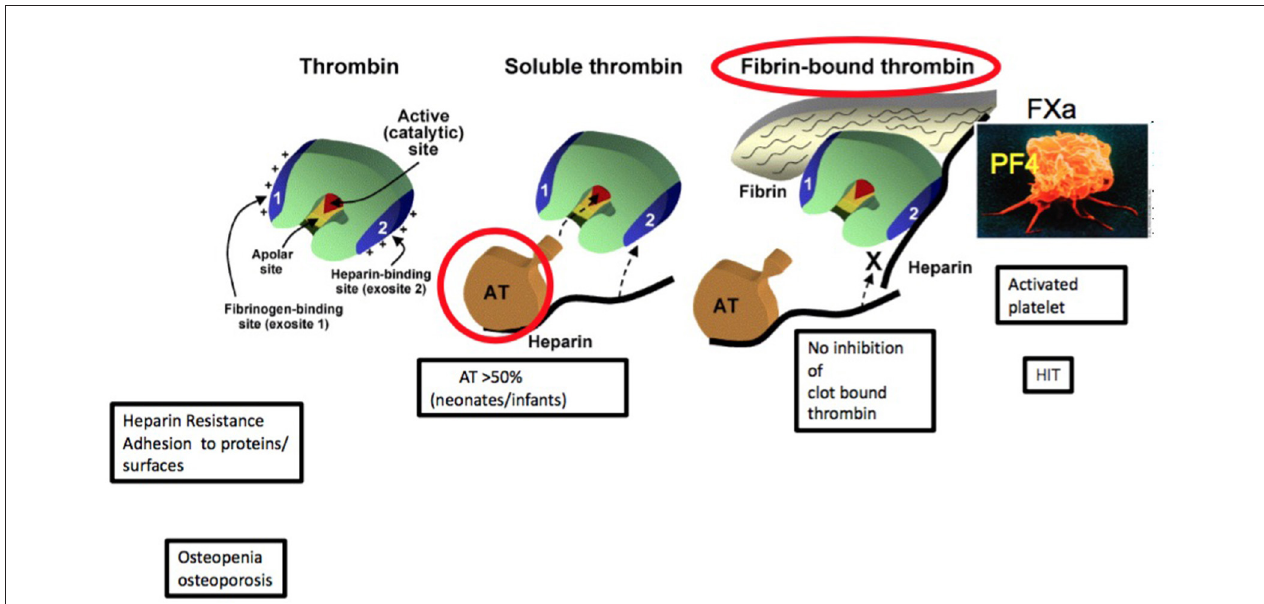
FIGURE 2 | Heparin mechanism (Modified by Patricia Massicotte. Warkentin TE. Best Practice & Research Clinical Haematology,